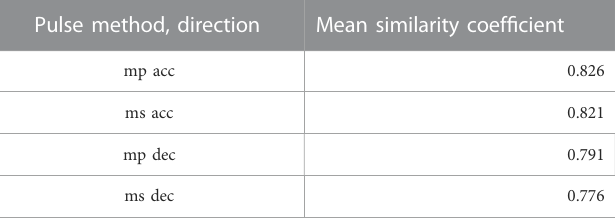
TABLE 1 Mean similarity coef fi cients of the average pulses according to maximum similarity (ms) and mean pulse (mp) method. Pulse method,